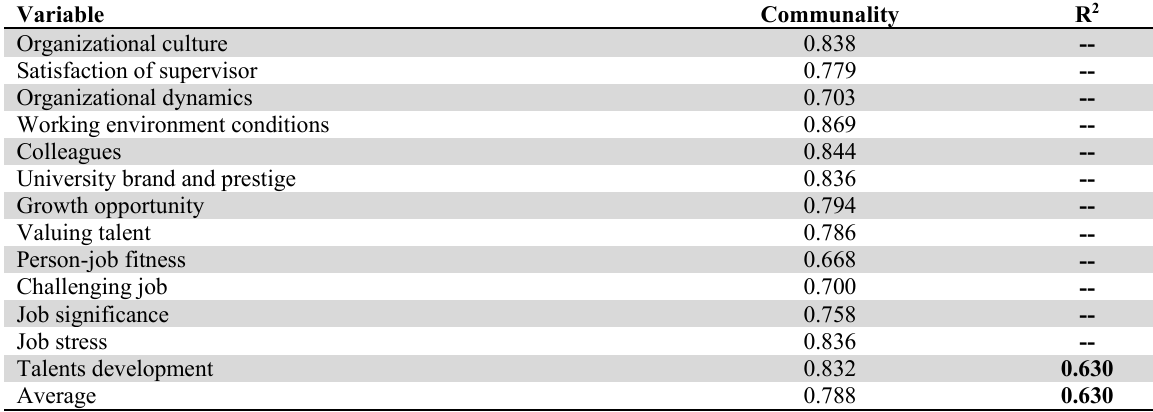
Communality and R-squared rate of variables of research